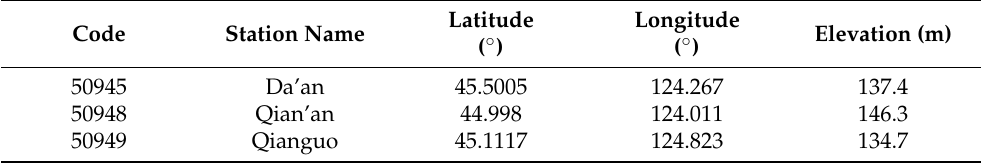
Table 2. The list of climate stations around Chagan Lake and the spatial distribution is shown in Figure 1.